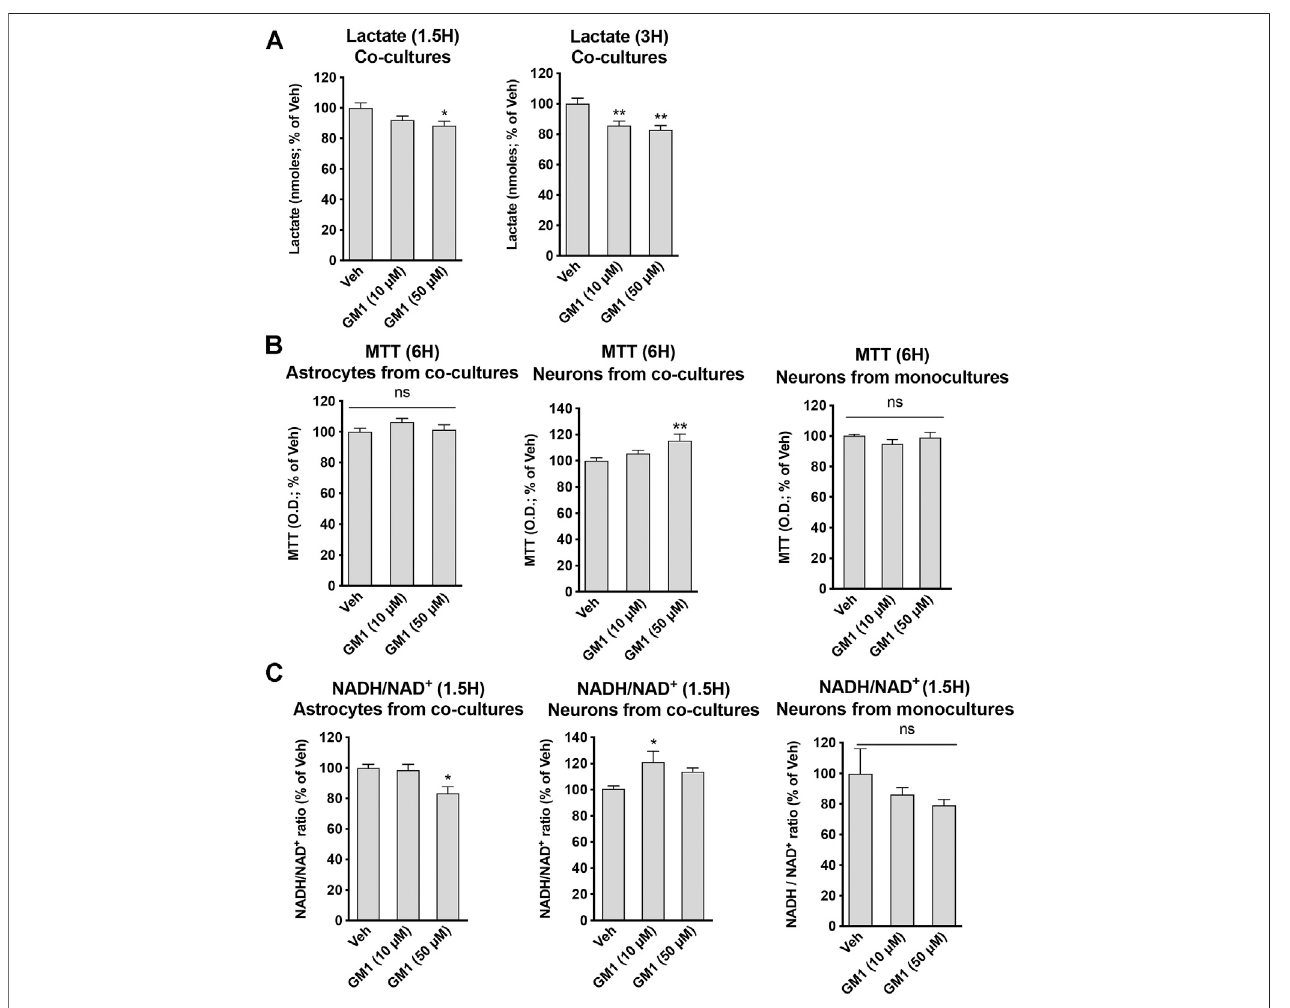
FIGURE 4 | Modulation of glycolytic activity, mitochondrial activity and redox state by GM1 in neuron-astrocyte co-cultures. (A) Extracellular secretion of lactate from astrocyte-neuron co-cultures after treatment with Veh (DMSO 0.1%) or GM1 (10 and 50 μ M) for 1.5 and 3 h. Data are shown as the average +SEM of extracellular lactate (nmoles) represented as % of Veh at 1.5 h ( n (cid:2) 12) (B) MTT assay used to monitor mitochondrial function in astrocytes (left panel) or neurons (center panel) from astrocyte-neuronco-cultures,orneuronsfrom monocultures (right panel) treatedwithVeh(DMSO0.1%) orGM1(10and 50 μ M) for6 h.Dataareshown as theaverage+SEMofopticaldensityofmitochondrialreductase-inducedformazan,representedas%ofVehat6 h( n (cid:2) 11 – 12) (C) NADH/NAD + redoxratioinastrocytes (left panel) or neurons (centerpanel) from astrocyte-neuron co-cultures, or neurons from monocultures (right panel) treated with Veh (DMSO 0.1%) or GM1 (10 and 50 μ M)for1.5 h.Dataareshownastheaverage+SEMofNADH/NAD + ratio,represented as%ofVeh( n (cid:2) 6).Statisticalanalysesconsistedinone-wayANOVAfollowed by Dunnett ’ s post-hoc test; * p < 0.05, ** p < 0.01, *** p <